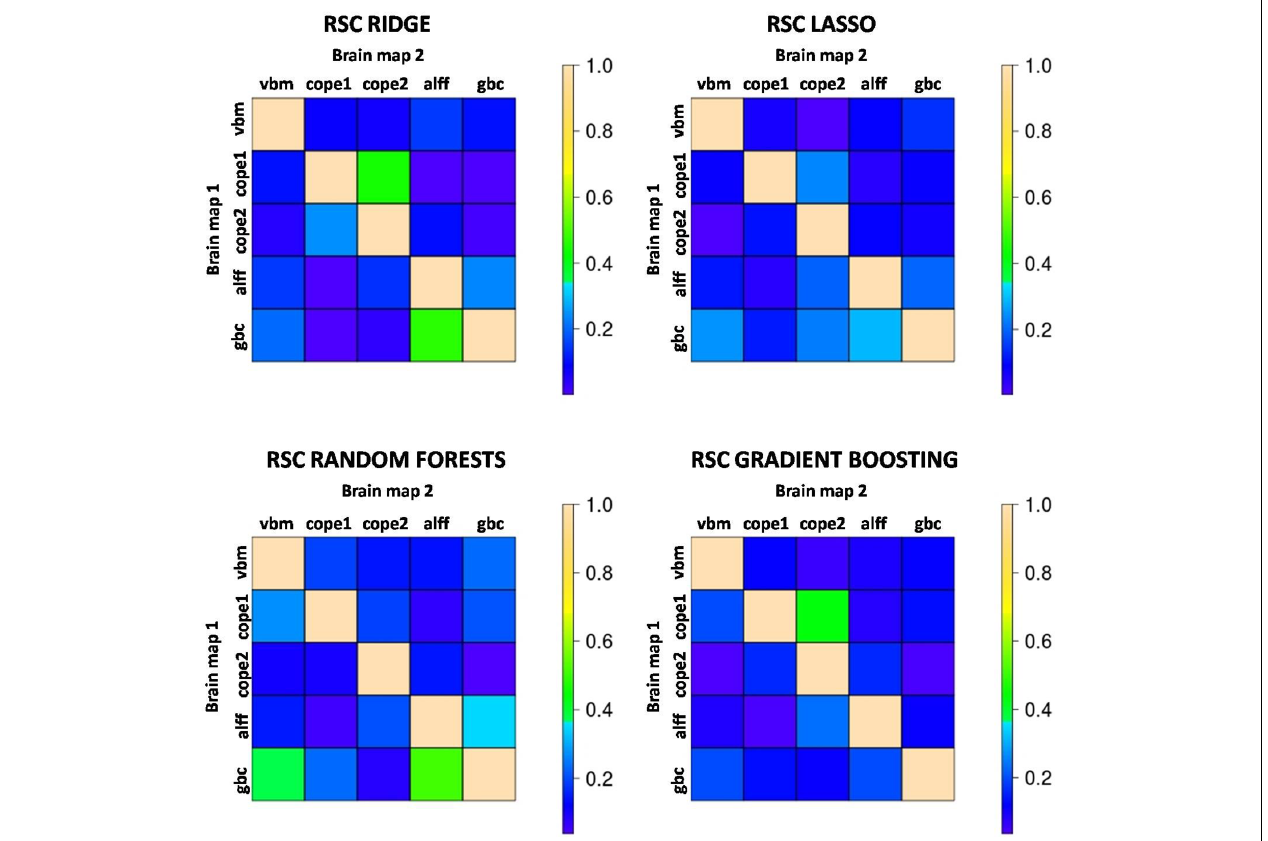
FIGURE 3 | Color-coded values for the redundancy scores (RSC) that quantify the degree to which predictive features of Brain map 2 are also present in Brain map 1. An RSC value close to 1 indicates that map 2 brings almost no predictive information apart from that contained in map 1 (high redundancy) while a value of RSC close to 0 indicates that map 1 contains hardly any of the predictive patterns present in map 2 (both maps convey independent information). The highest RSCs tend to occur between maps derived from the same image modality, although these hardly ever reach values > 0.50. Most of the RSCs are well below this number, indicating very low levels of redundancy and potential increases in accuracy through multimodal integration. cope1: 1back maps; cope2: 2back